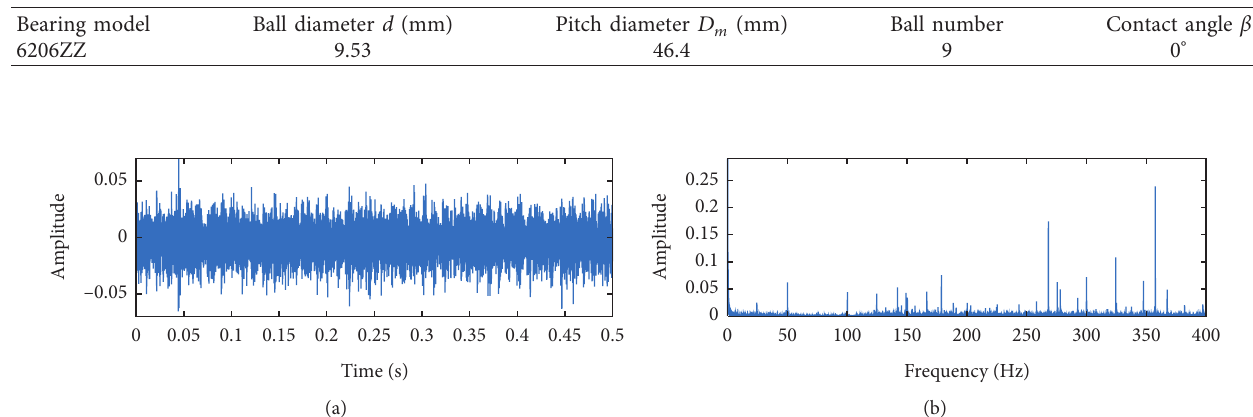
Figure 10: The fault mode: outer race fault. Table 2: Kinematical parameters of the experimental bearings.